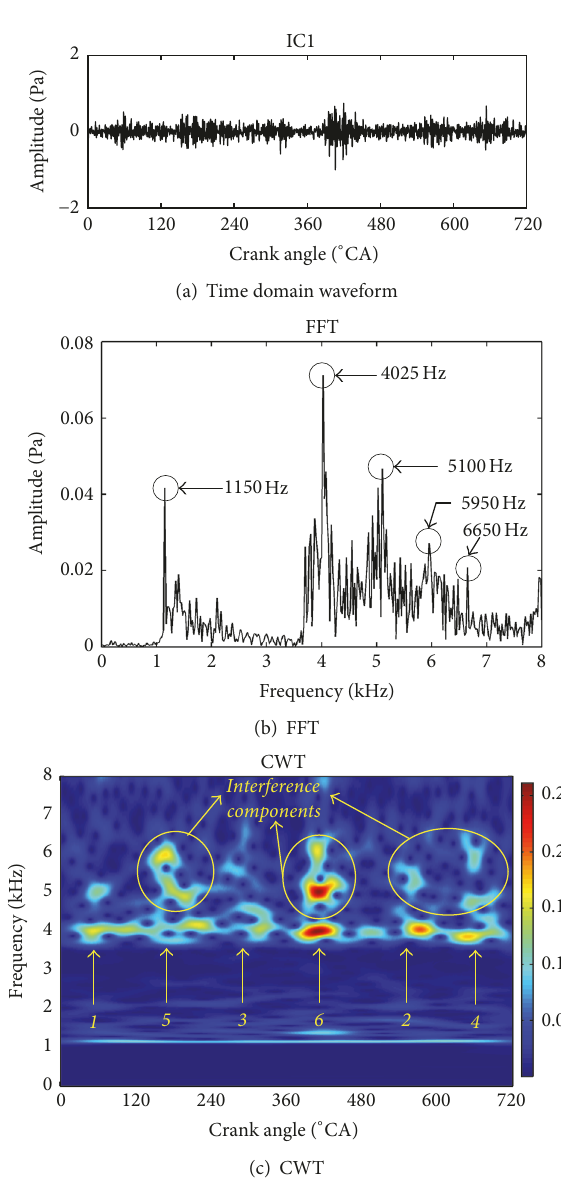
Figure 21: Time domain waveform, FFT, and CWT of IC1 by the EWT-RobustICA